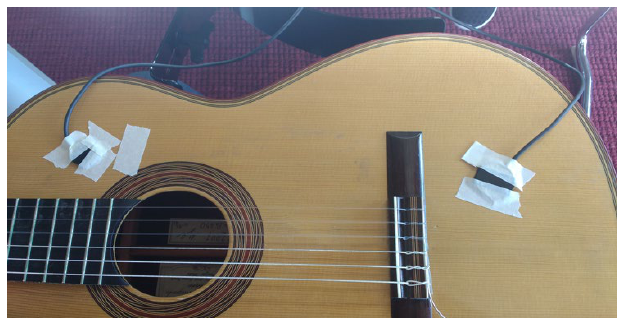
Figure 2. Piezoelectric microphones on the soundboard.